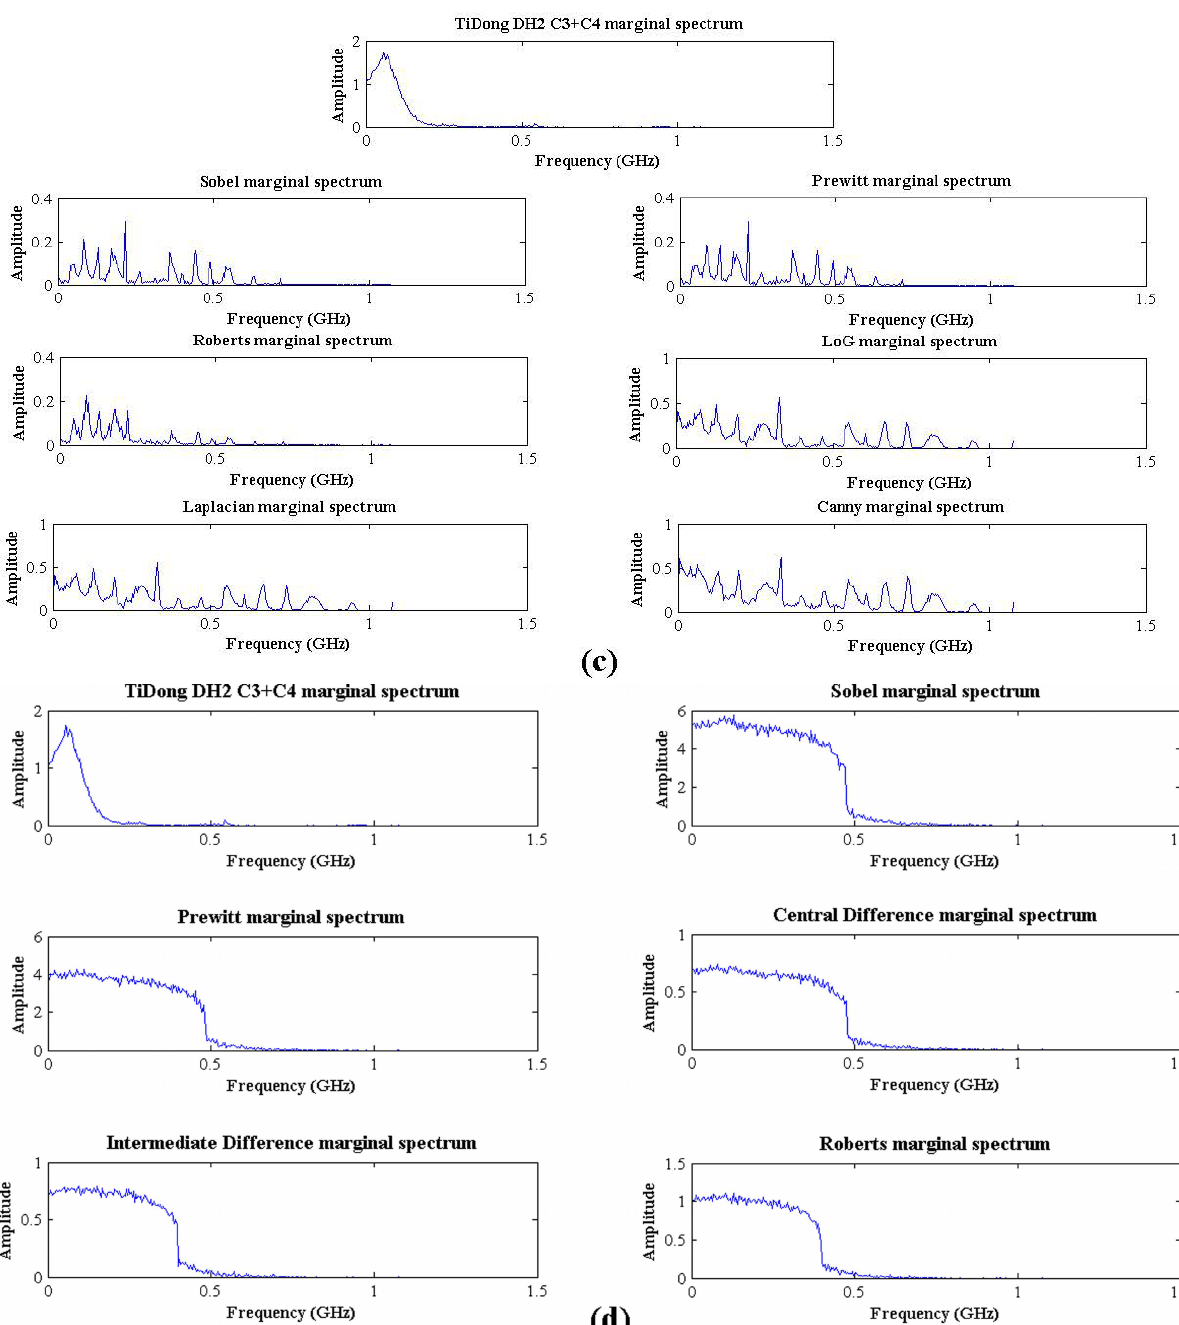
Figure 12. Marginal spectra of field data before and after processing. ( a ) Marginal spectra of the original profile and those of its binary edge maps derived from various edge detectors. ( b ) Marginal spectra of the original profile and those of its two-dimensional edge maps derived from various edge detectors. ( c ) Marginal spectra of MDEEMD reconstructed profile and those of its binary edge maps derived from various edge detectors. ( d ) Marginal spectra of MDEEMD reconstructed profile and those of its two-dimensional edge maps derived from various edge